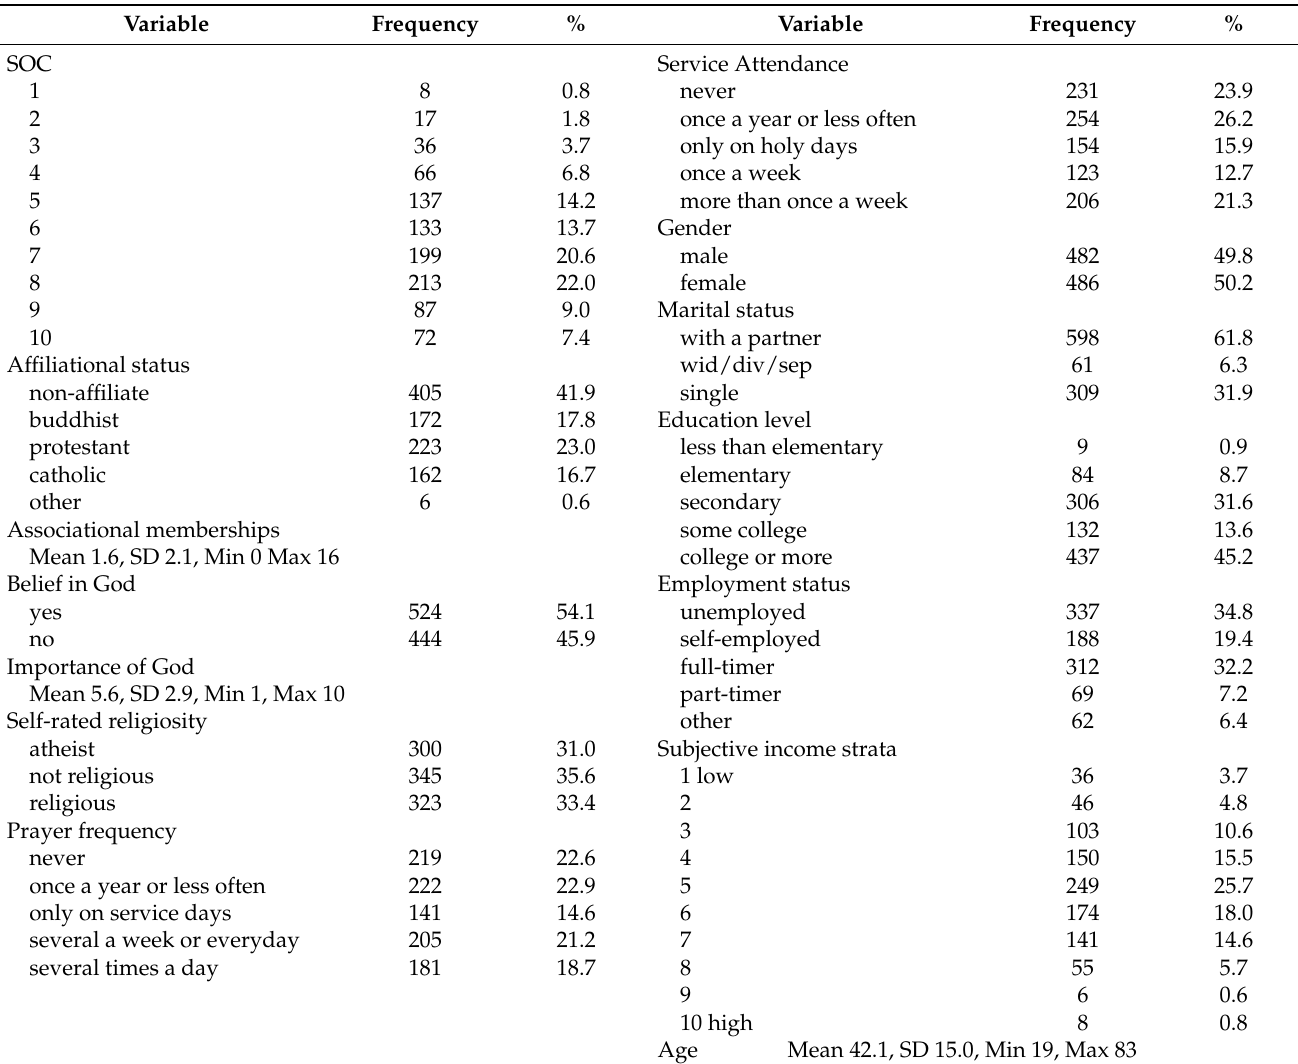
Table 1. Descriptive statistics (N =